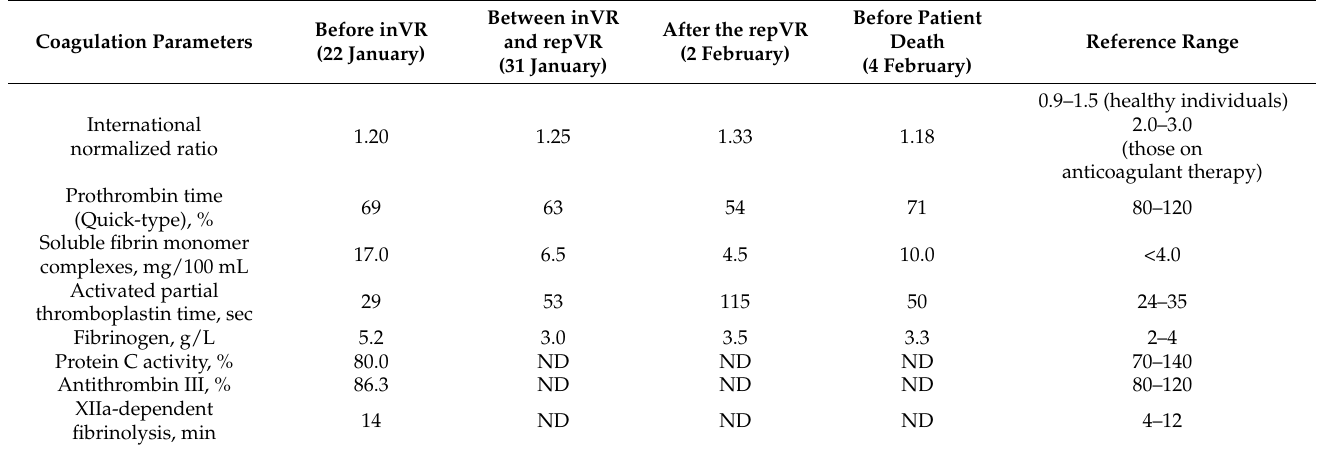
Table 1. Coagulation parameters before and after the mitral valve